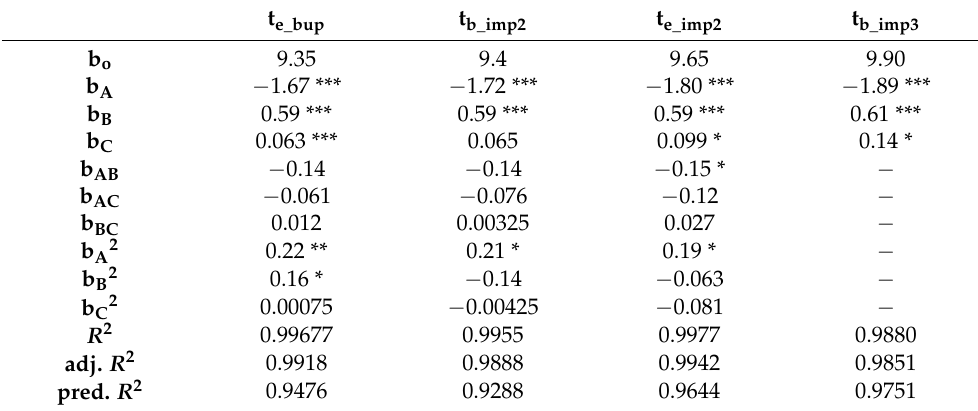
Table 3. Coefficients of the obtained models and their statistical